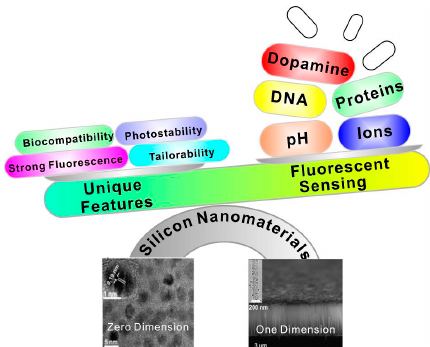
Figure 1. Silicon nanomaterial-based fluorescent sensors constructed by using zero- and one-dimensional silicon-based nanomaterials featuring several merits, and their use for various sensing applications. (Zero-dimensional silicon nanoparticles (SiNPs) image was reproduced with permission from ref. [23]. Copyright 2015, American Chemical Society. One-dimensional silicon nanowires (SiNWs) image was reproduced with permission from [24]. Copyright 2014, John Wiley & Sons, Inc.)